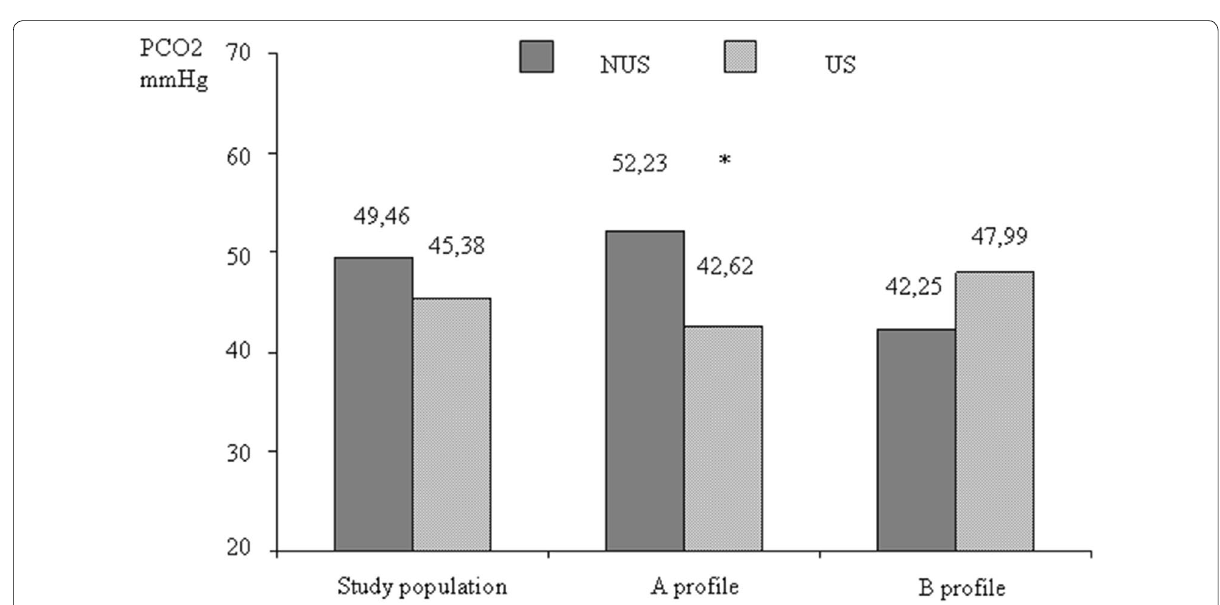
Fig. 2 PCO 2 concentration in the two study groups splitted by lung